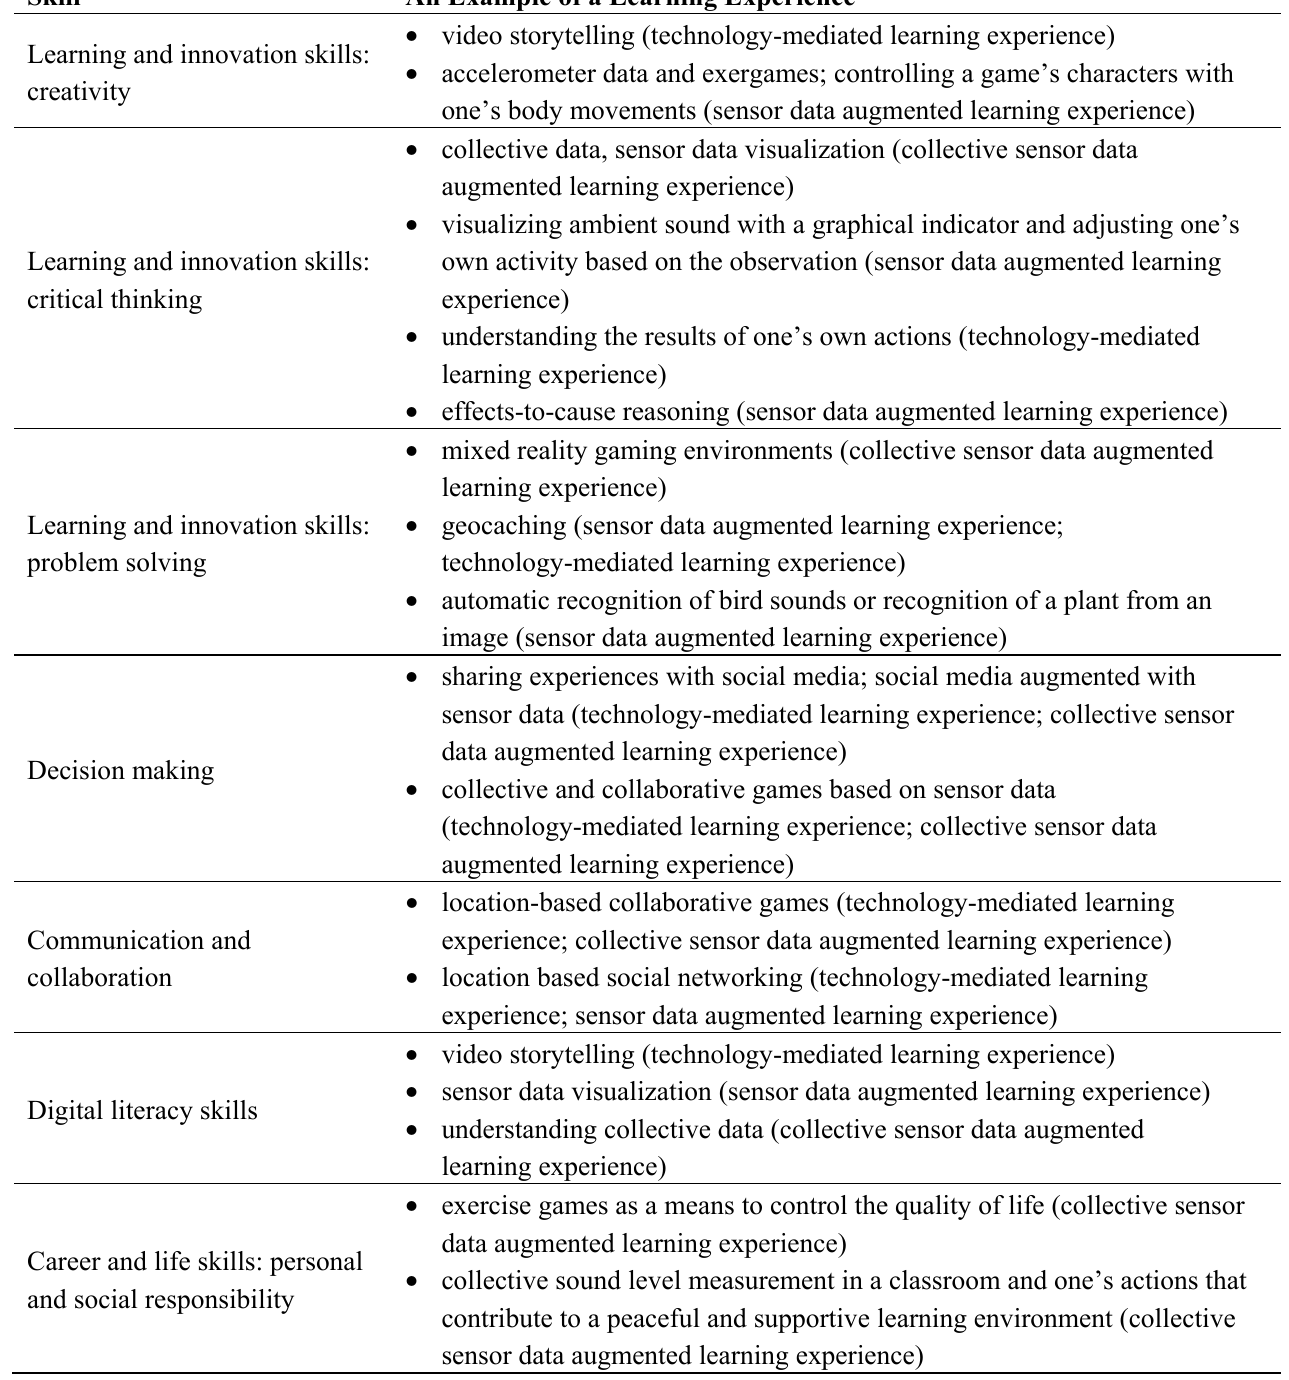
Table 1. Learning experiences augmented with (collective) sensor and twenty first century